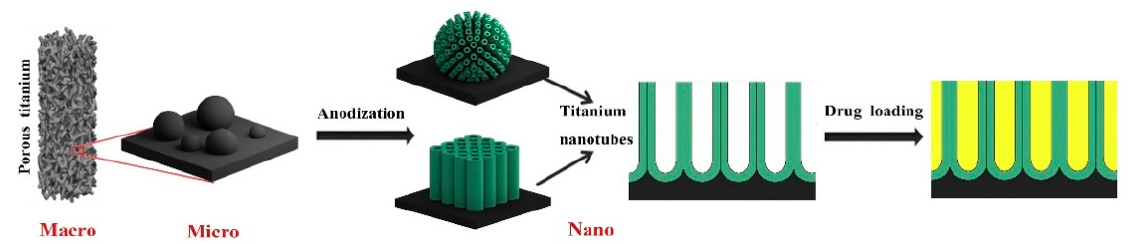
Figure 5. AM Ti implants with unique micro- and nanotopography, which can be used as a nano drug delivery system by combining AM technology and anodization. Adapted with permission from ref. [116]. Copyright 2020 Elsevier.